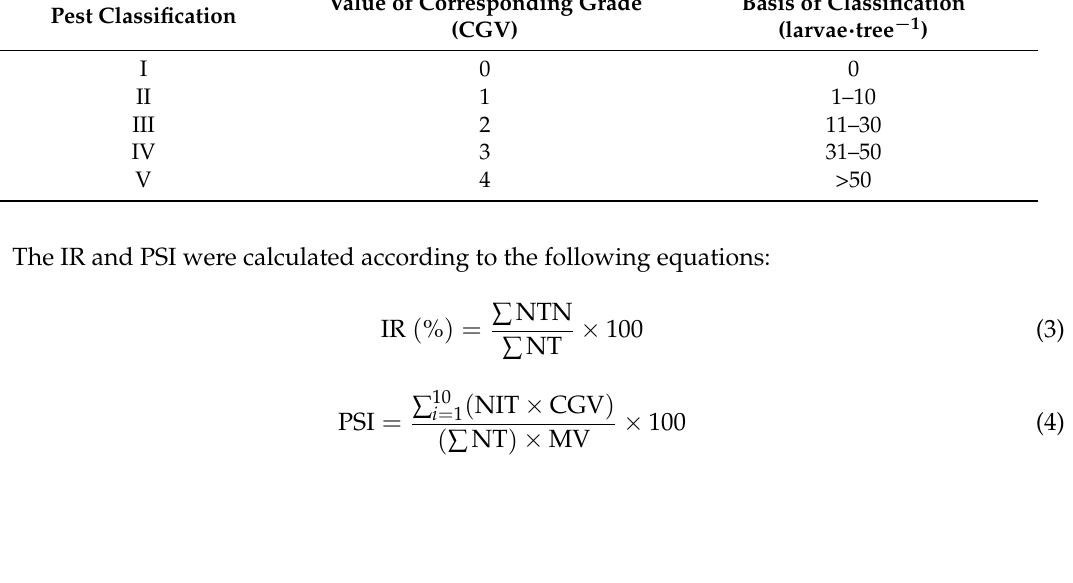
Table 1. The pest classification standard of the C. Kunyushanica per tree. Pest